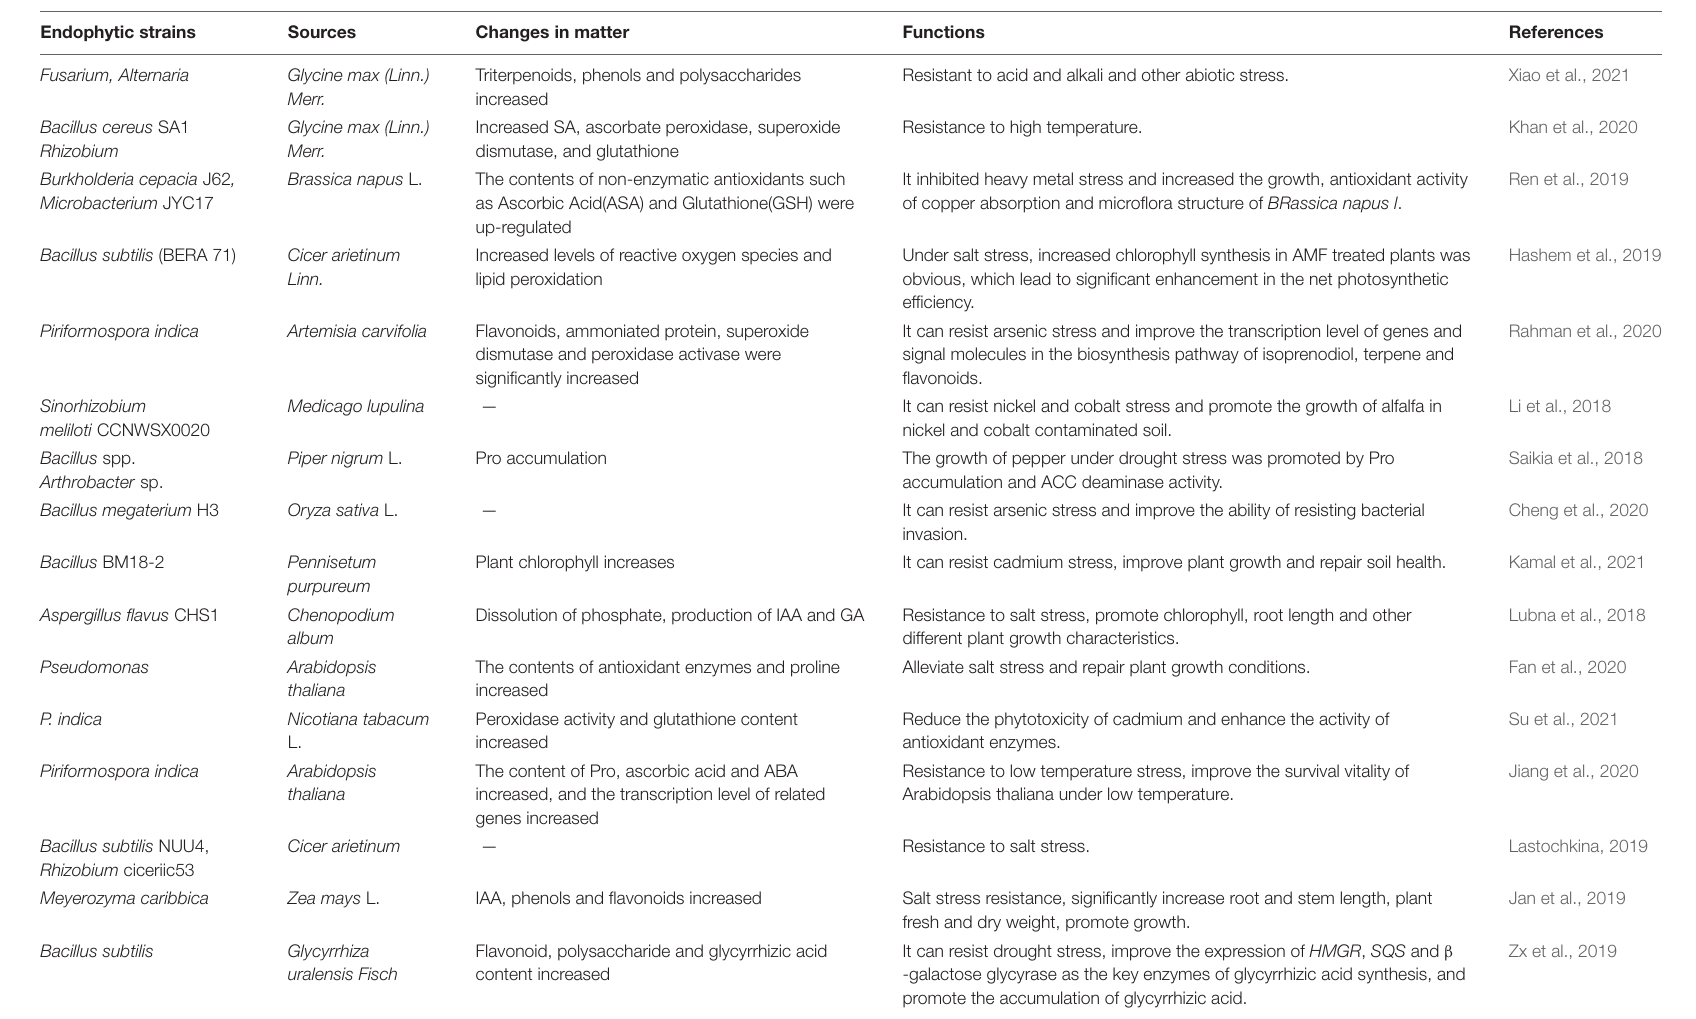
TABLE 2 | Effect of endophytes on host abiotic stress